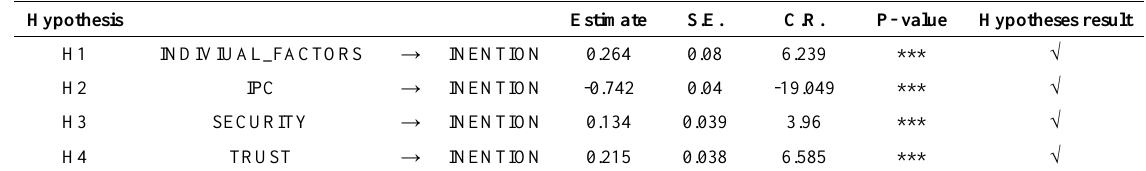
Table 3. Coefficients and direct effects hypothesized